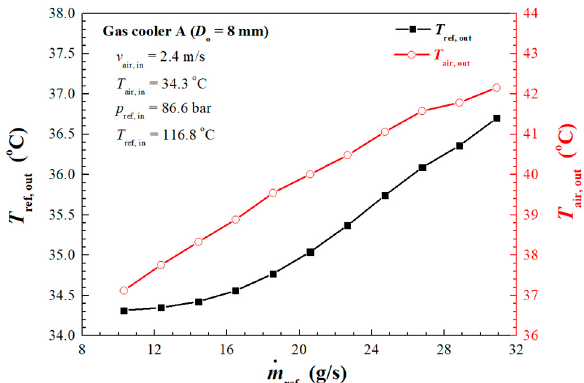
Figure 8. Influence of refrigerant mass flow rate on outlet temperature of sCO 2 and air for gas cooler A.